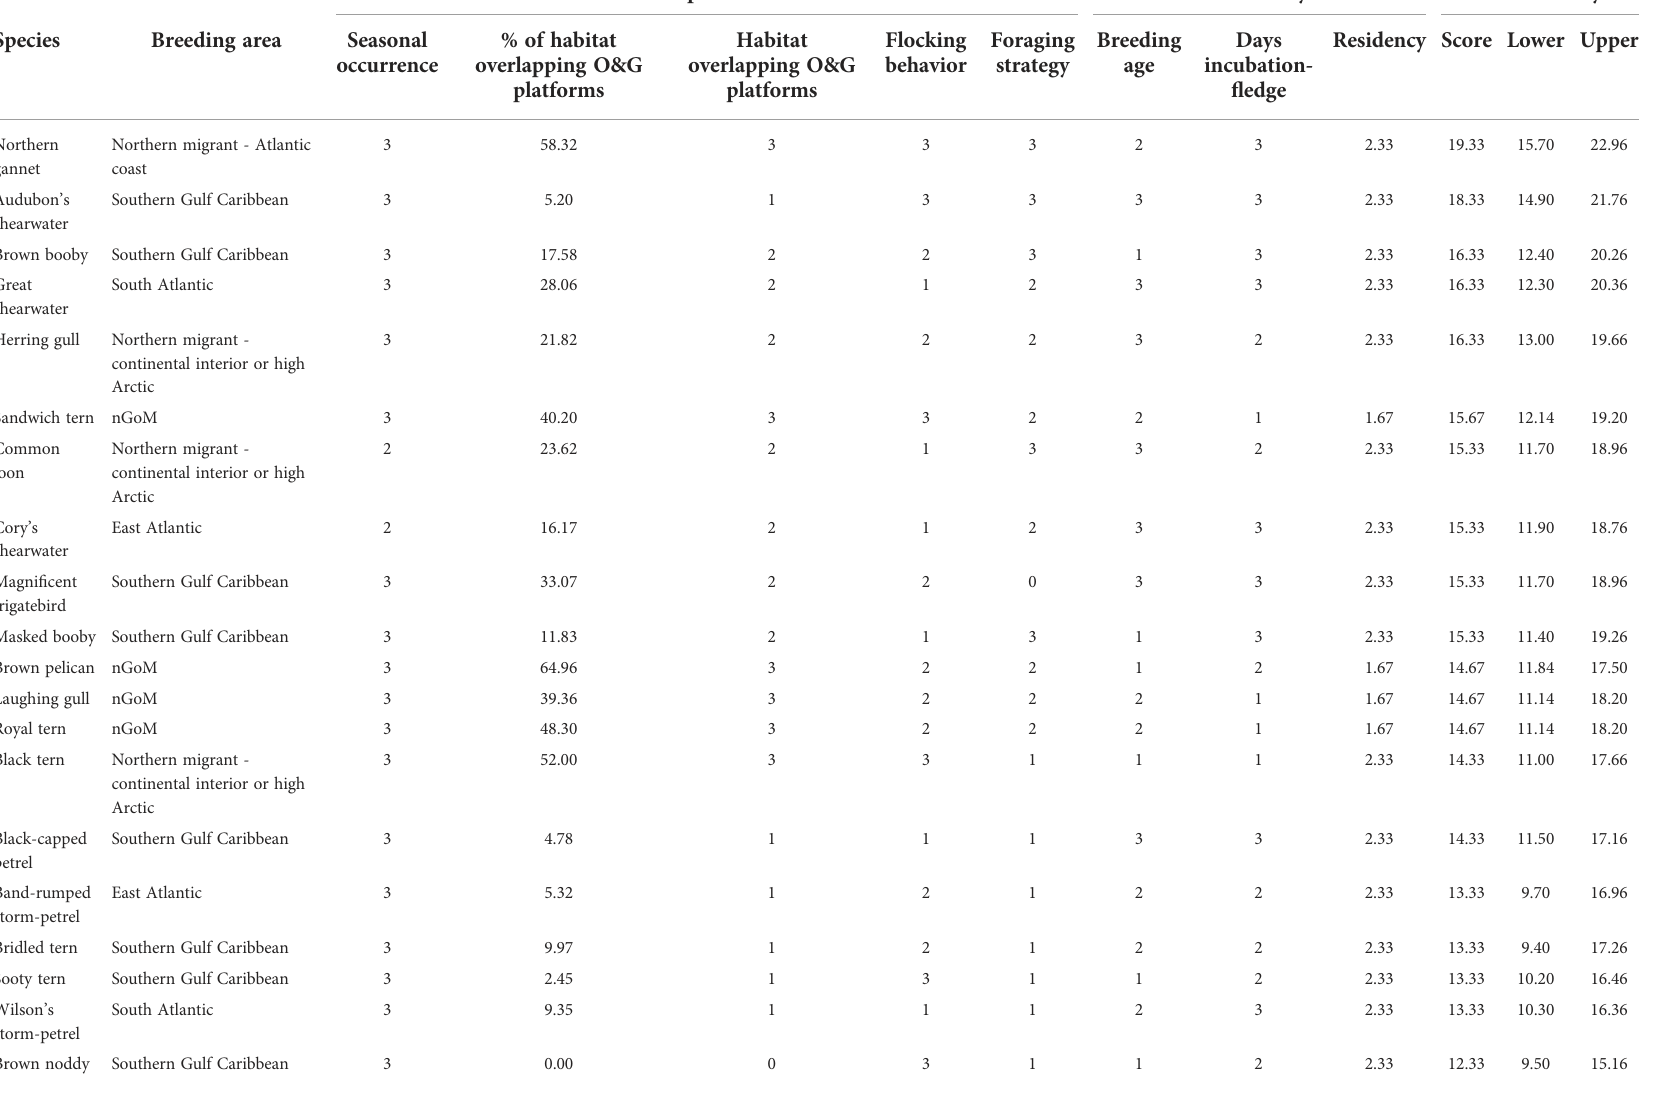
TABLE 2 Variable scores, uncertainty, and overall vulnerability of seabirds to oiling in the northern Gulf of Mexico (nGoM). Exposure Sensitivity Vulnerability Species Breeding